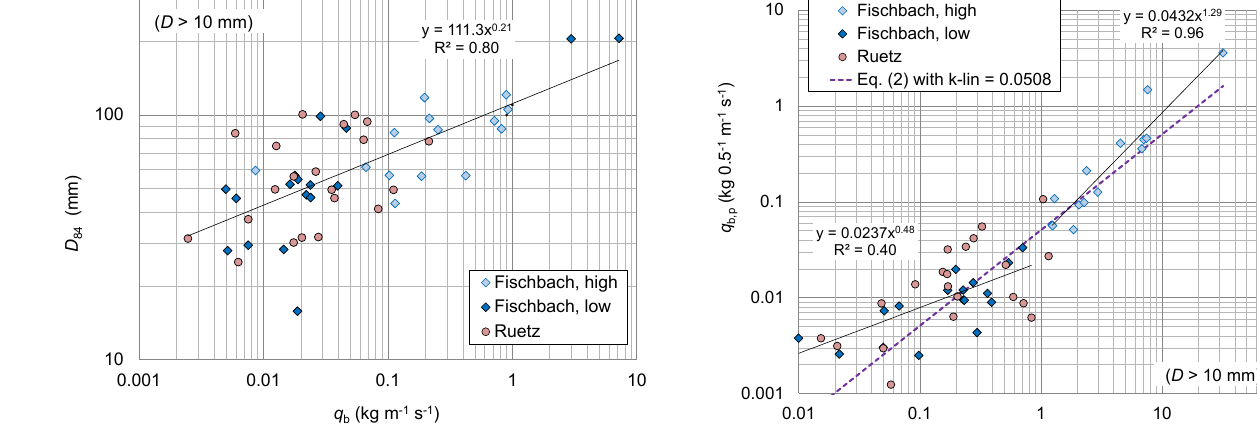
Figure 10. Unit bedload transport rate q b, p for particles D > 10mm vs. impulse rate IMPT. Fischbach: data points marked “high” and “low” refer to IMPT values higher and lower than 1 (0.5 − 1 m − 1 s − 1 ), respectively. The regression lines are based on the Fischbach data only. The violet dashed line represents the linear cal- ibration relation Eq. (2) determined for the Fischbach data based on a regression of M vs.